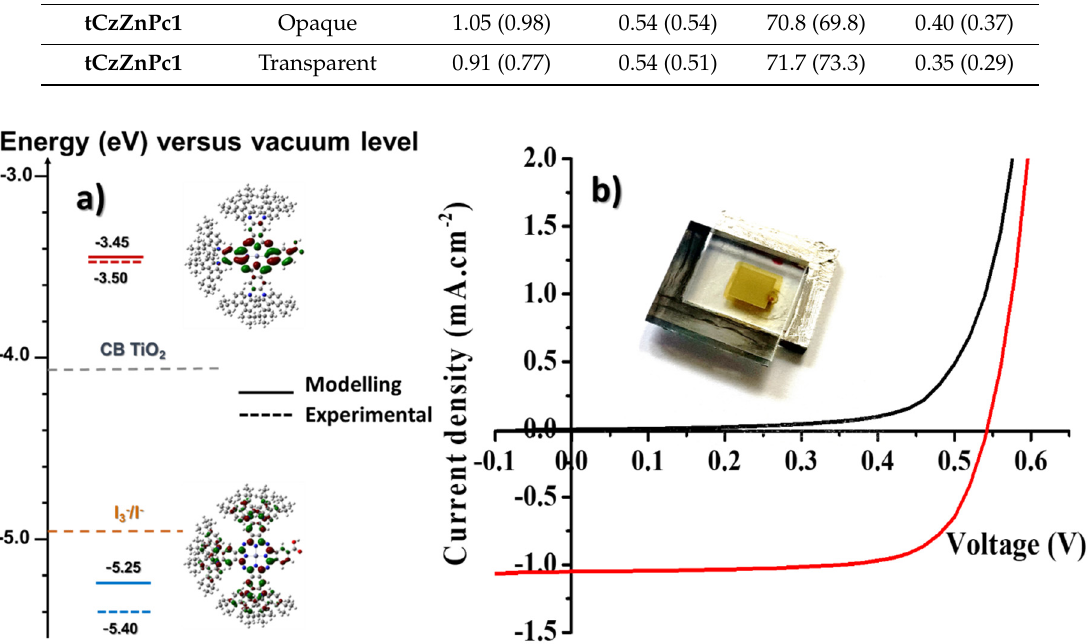
Figure 3. ( a ) Energy band diagram of the DSSC fabricated in this work. ( b ) Current–voltage curves of an opaque tCzZnPc1 -based device recorded in the dark (black line) and under irradiation (red line) under AM 1.5G (1000 W·m − 2 ) irradiation condition.